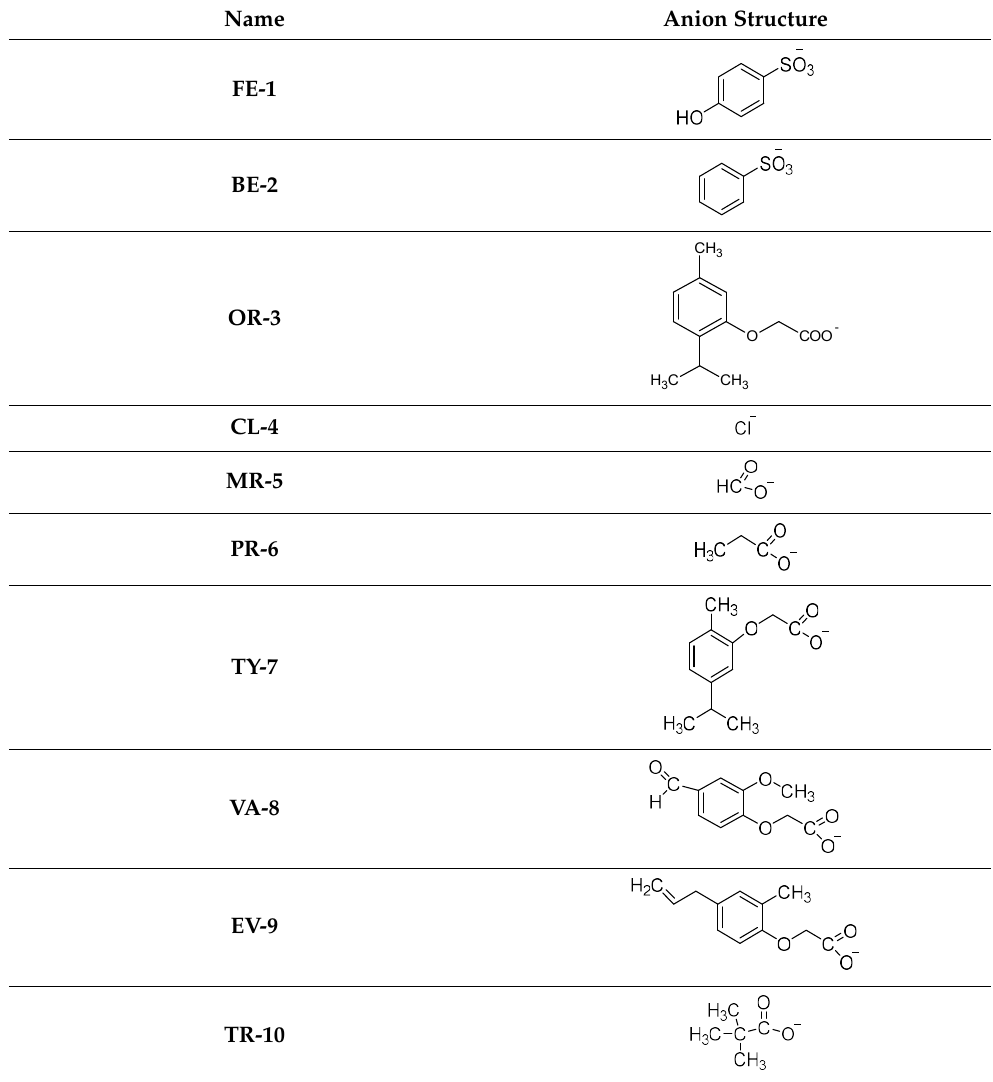
Table 1. Chemical Structure of Anions of New ILs.